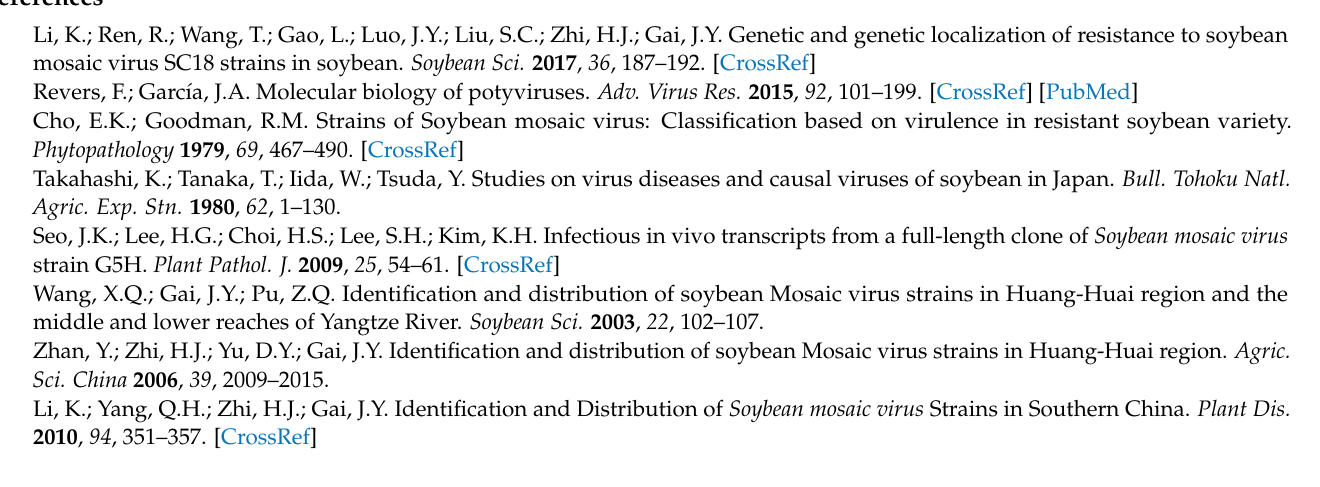
qRT-PCR validation; Table S2: The quality and concentration measurements of RNA sample; Table S3: Filtering and quality testing of raw data: Tables S4: Statistics of RNA-Seq map; Table S5: Comparison of regional statistics; Table S6: Function of candidate